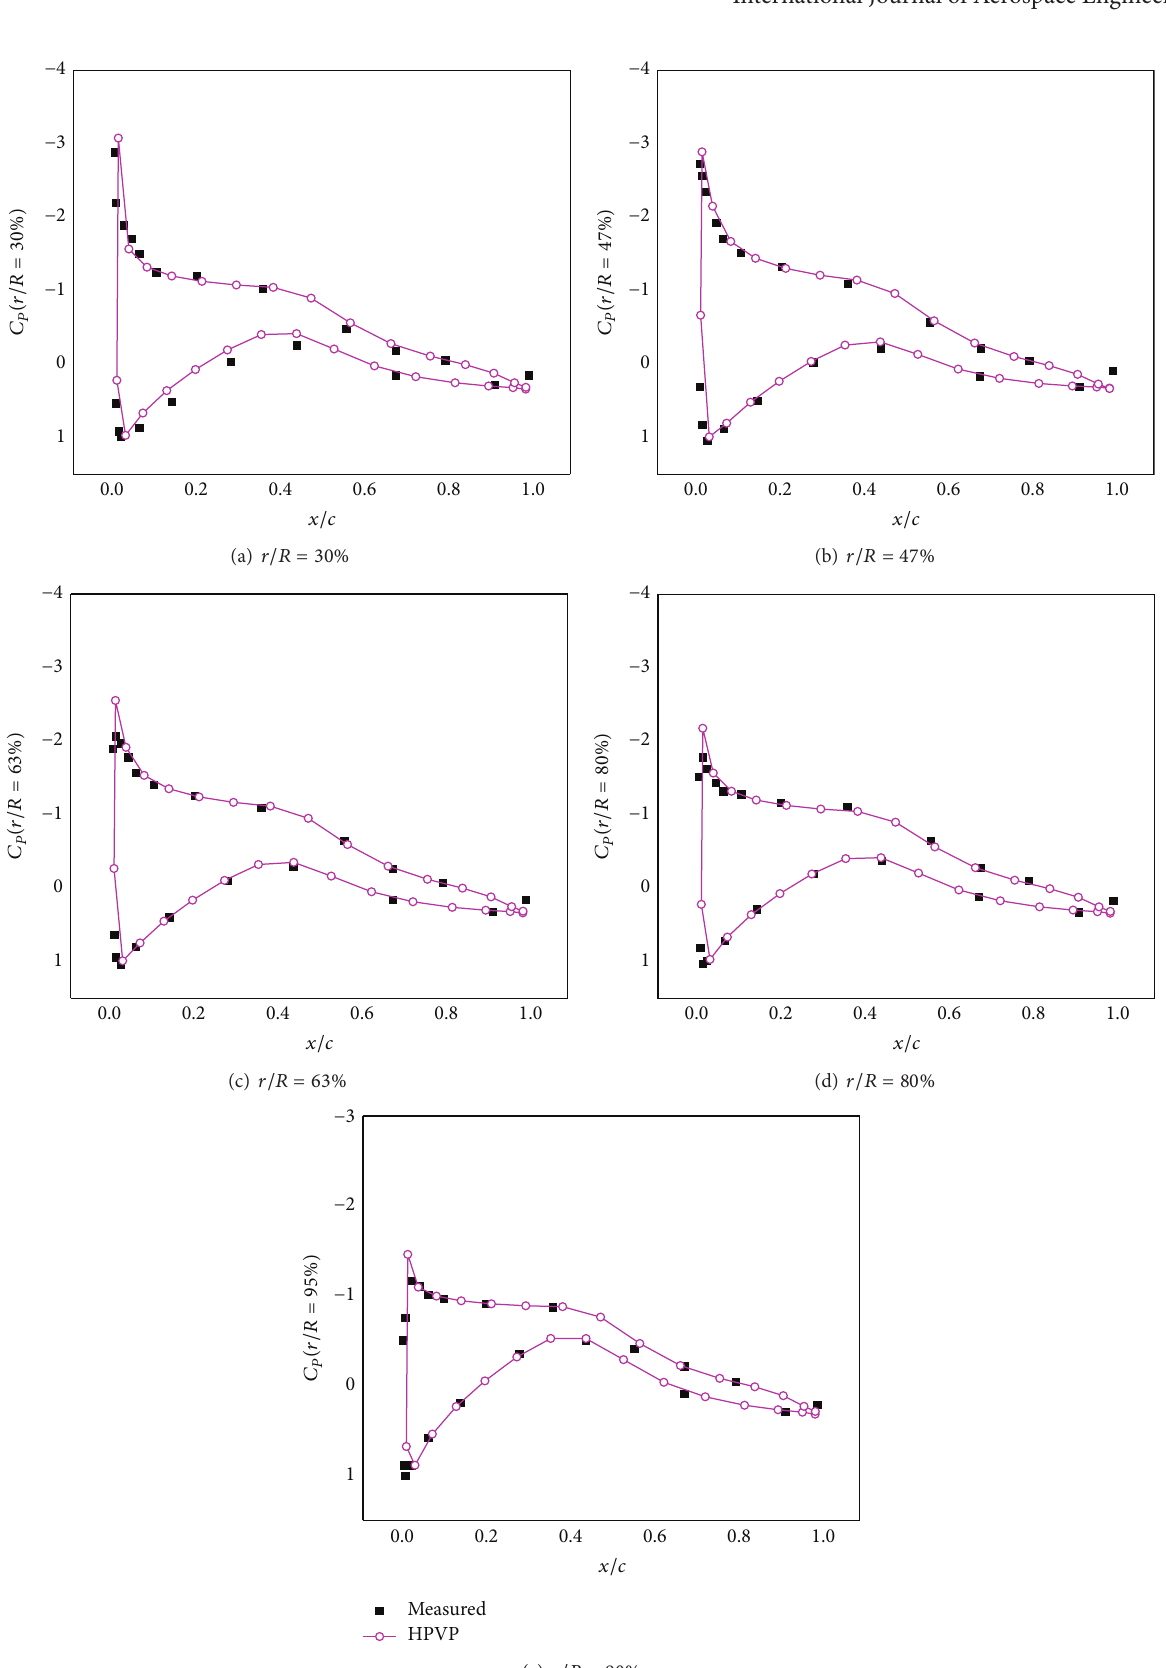
Figure 6: Cross pressure coefficients comparisons between the test and HPVP